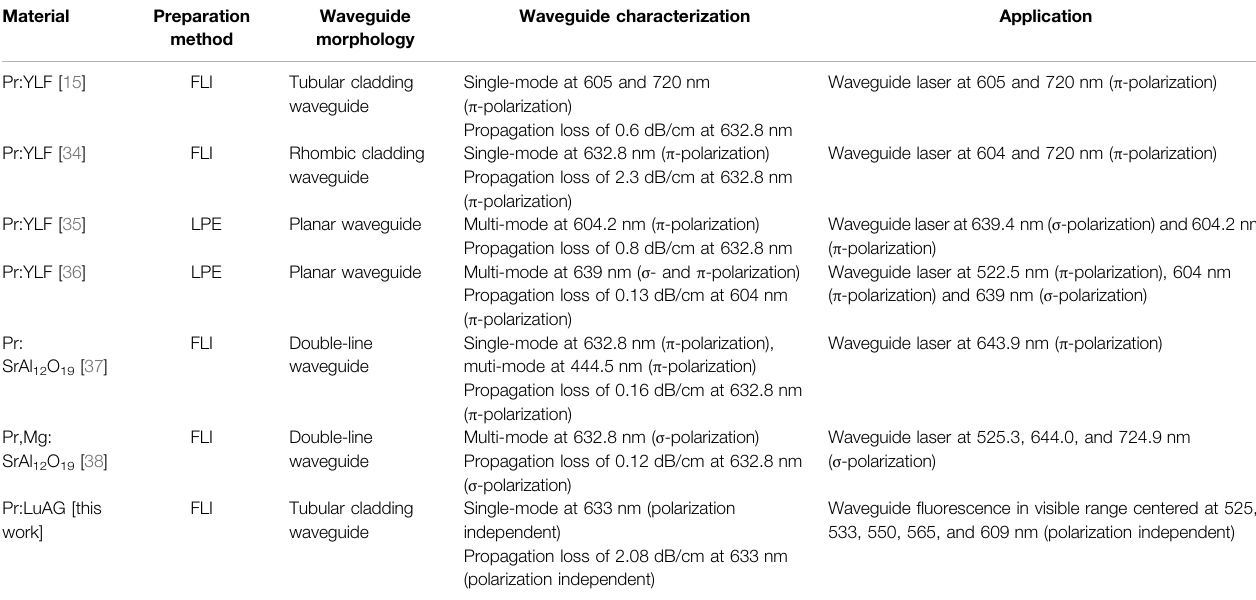
TABLE 1 | Comparison of waveguides fabricated in Pr 3+ doped crystalline materials. Material Preparation